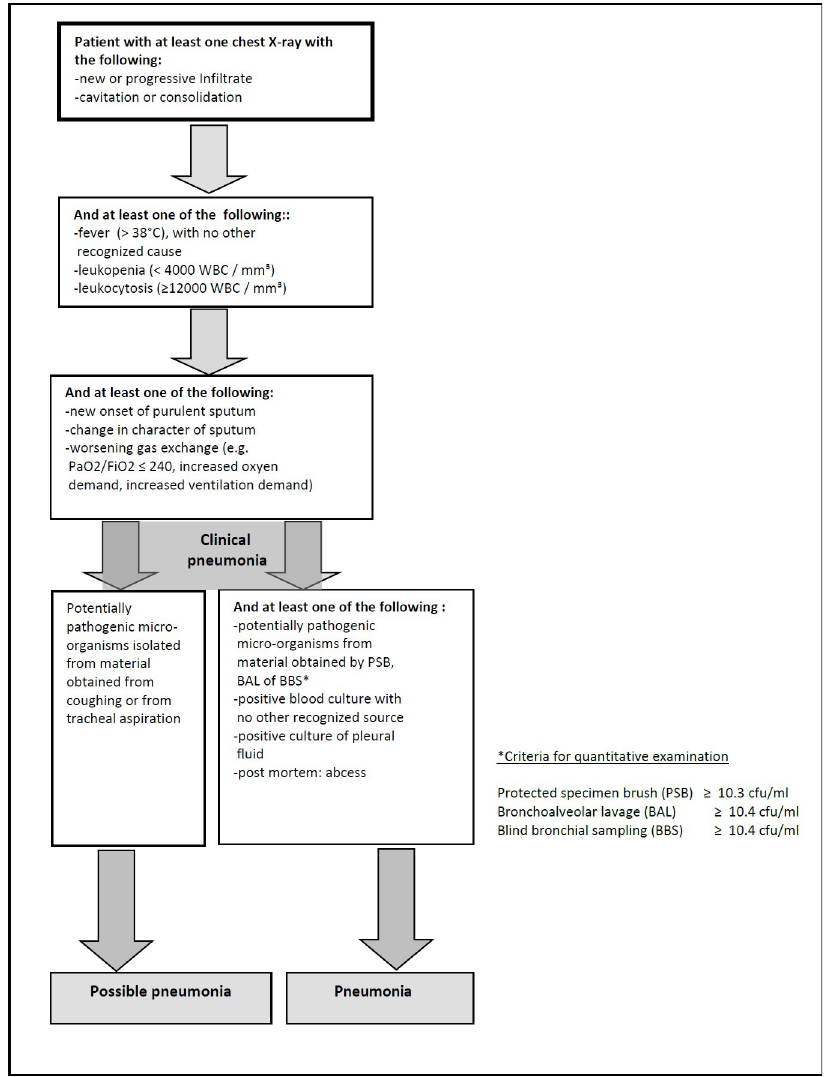
Fig 1. Diagnostic diagram for ventilator-associated pneumonia, based on the definitions of the former Centers for Disease Control and Prevention/National Nosocomial Infections Surveillance system, currently the National Healthcare Safety